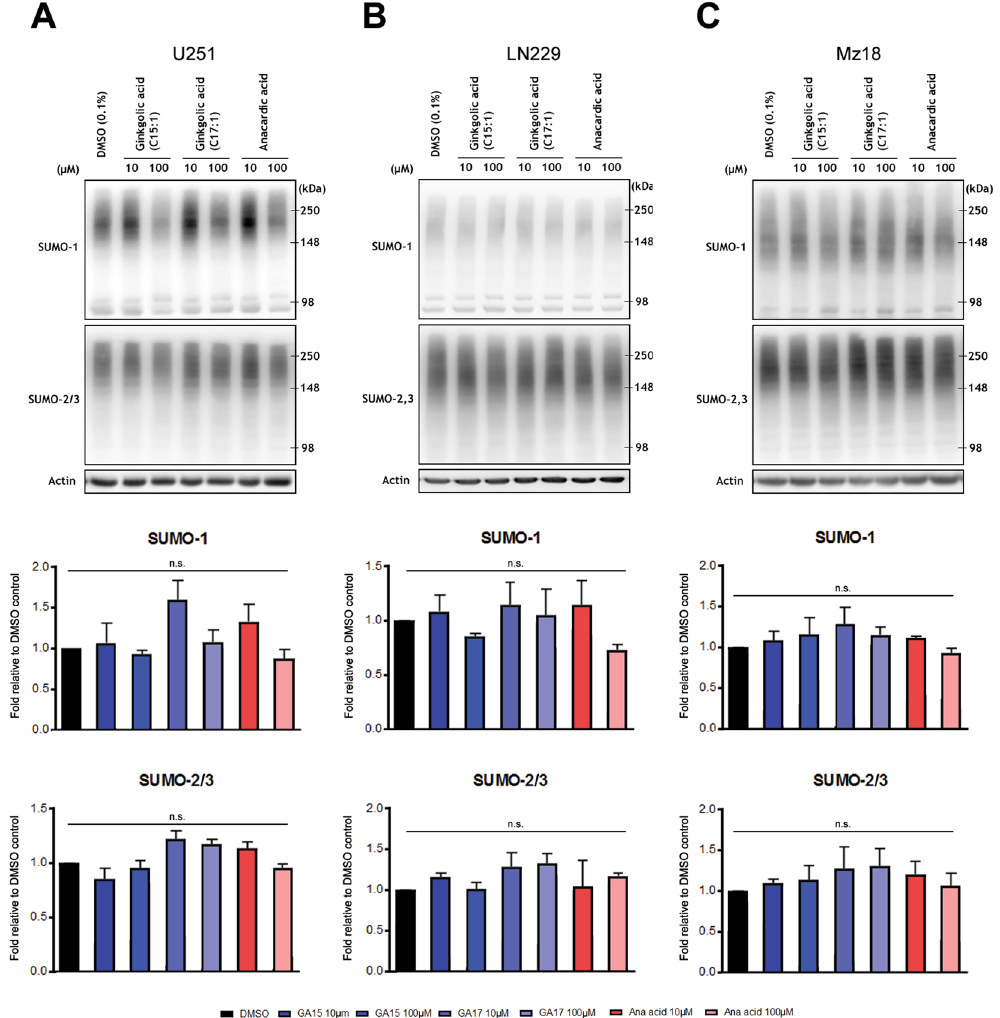
Figure 1. Ginkgolic and anacardic acid fail to suppress global SUMO-conjugation in human GBM lines. U251 ( A ), LN229 ( B ), and Mz18 ( C ), at concentrations of 10 μ M or 100 μ M. Representative immunoblots are shown. High molecular weight ( > 100 kDa) SUMO-1 and SUMO-2/3 conjugates were cropped in each lane and the total intensities were measured. Densitometries were normalized to corresponding actin levels and expressed as a fold difference relative to the control (DMSO). Data are means ( ± SD) from n = 3 independent